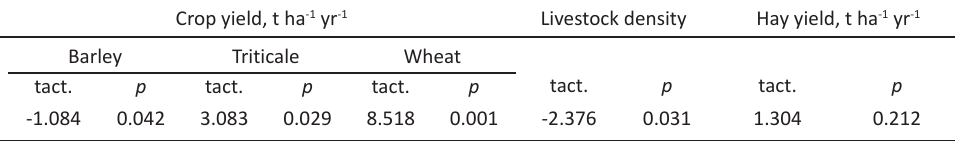
Table 4. A paired t-test results on differences between LFAs and non-LFAs